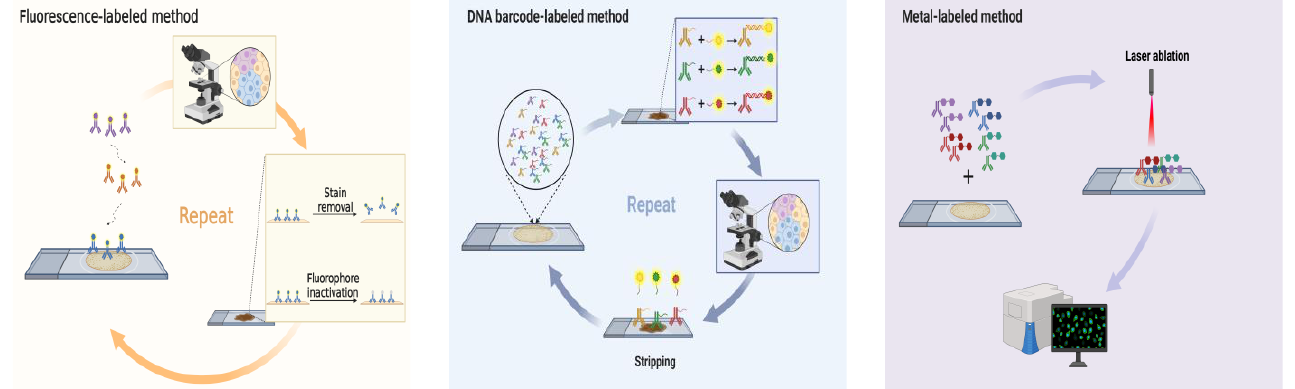
Figure 1. Schematic diagram showing the mechanism of each multiplex fluorescent immunohisto- chemistry method and was created with BioRender.com. Fluorescence-labeled method: multiepitope-ligand cartography (MELC), sequential immuno-peroxidase labelling and erasing (SIMPLE), iterative bleaching extends multiplexity (IBEX), multiplexed fluorescence microscopy (MxIF), cyclic immunofluorescence (CycIF), ChipCytometry, UltraPlex™, Opal™, quantum dots (QDs). DNA bar- code-labeled method: DNA Exchange Imaging (DEI), codetection by indexing (CODEX), Immuno- SABER, Digital Spatial Profiling (DSP), InSituPlex ® . Metal-labeled method: imaging Mass Cytome- try (IMC), multiplexed ion beam imaging (MIBI). Created with BioRender.com. Table 1. Overview the mfIHC technologies.